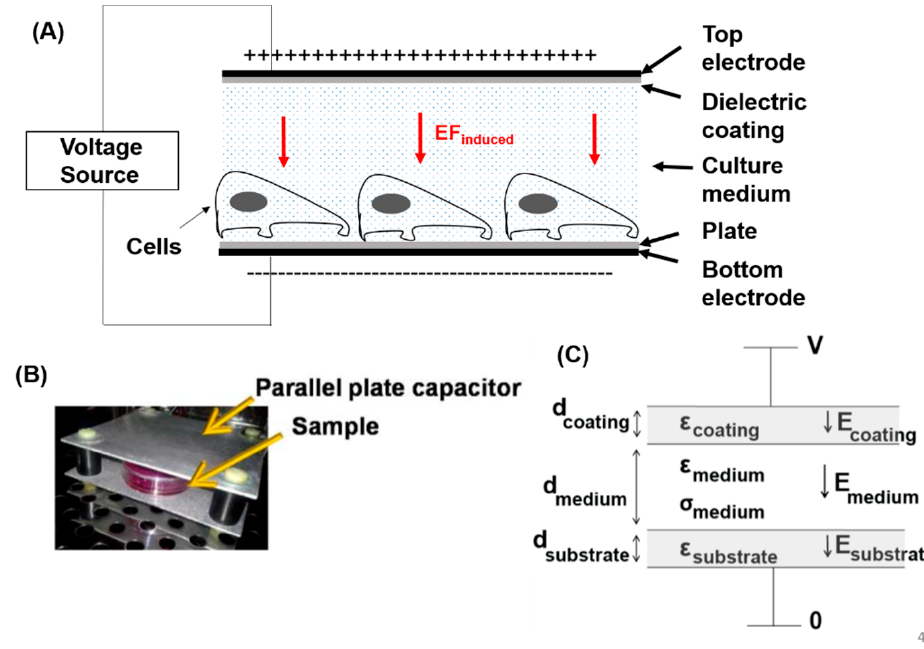
Figure 4. A custom system for direct current electric field (DC-EF) electrical stimulation of cells using the low-amplitude electric field and capacitive coupling method. ( A ) Schematic of the setup, where